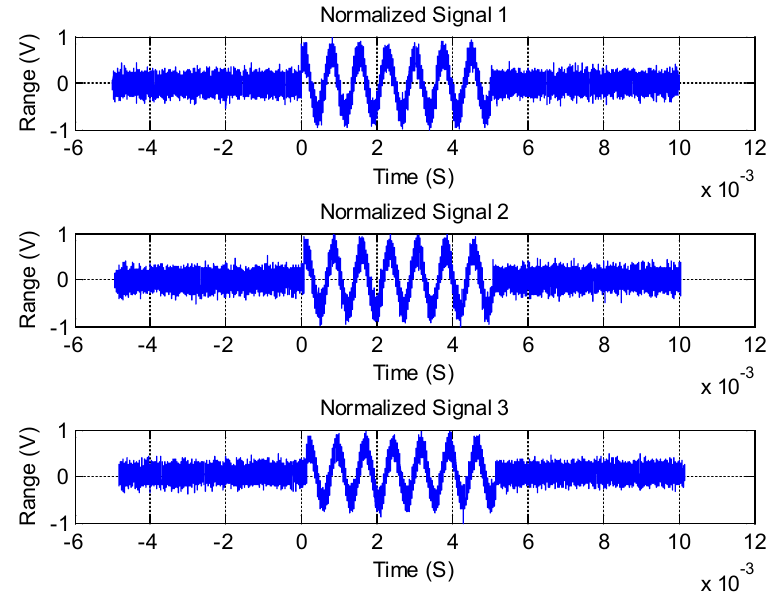
Figure 6. The three-way received signal waveform diagram.